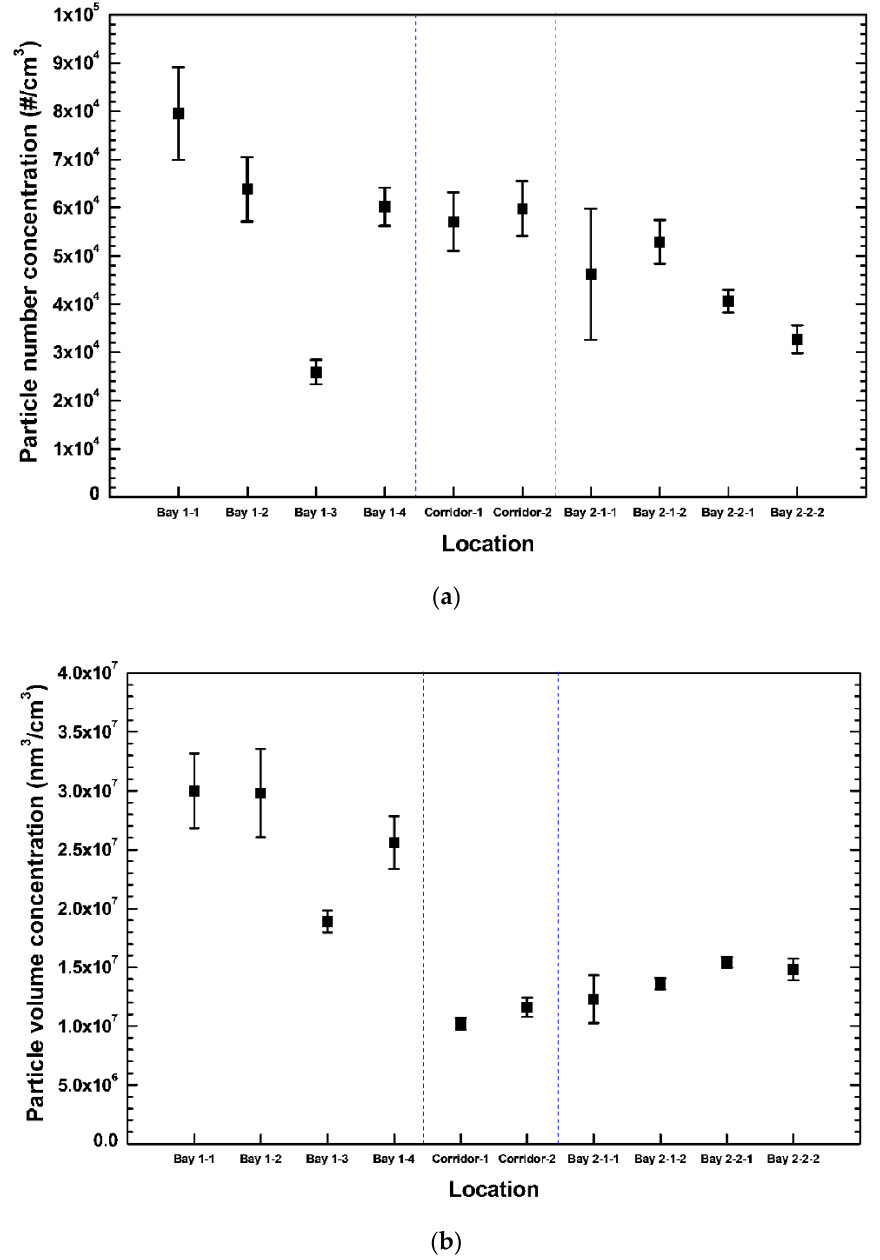
Figure 3. ( a ) Total particle number and ( b ) volume concentrations measured at different sub-locations in the cleanroom at the University of Minnesota by the portable AMC detector through soft X-ray radiolysis. 169